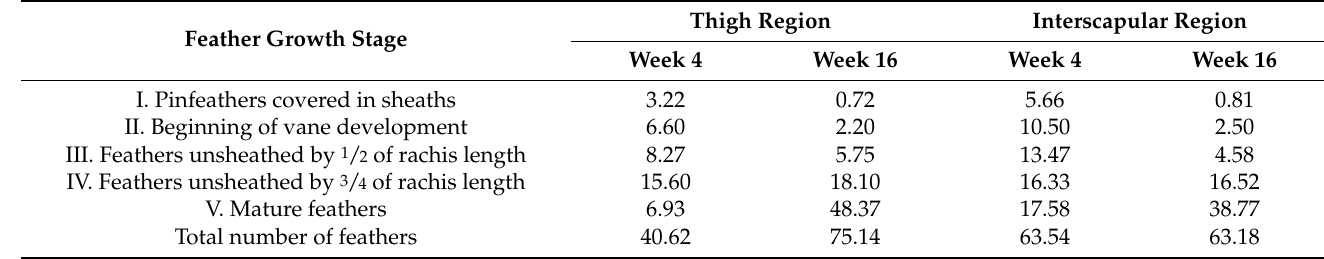
Figure 4. Interscapular feathers in a 16-week-old turkey. Feather growth stages: I—pinfeather covered in sheath; II—barbs protruding from the sheath; III—feather unsheathed by 1 / 2 of rachis length; IV—plumulaceous (loose) vane and pennaceous (coherent) vane, feathers unsheathed by 3 / 4 of rachis length; V—mature feathers, feather length: shortest—3.5 cm, longest—5.0 cm, afterfeathers and empty spaces between barbs. Table 1. Average number of feathers in the analyzed body regions of